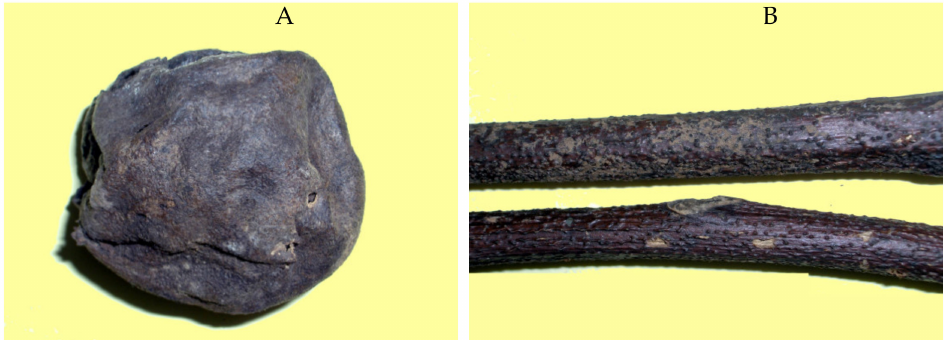
Figure 1. Phomopsis juglandina (Sacc.) Höhn. ( A )—attack on fruit; ( B )—the stage with abundant pycnidia on the branches, 30 days after